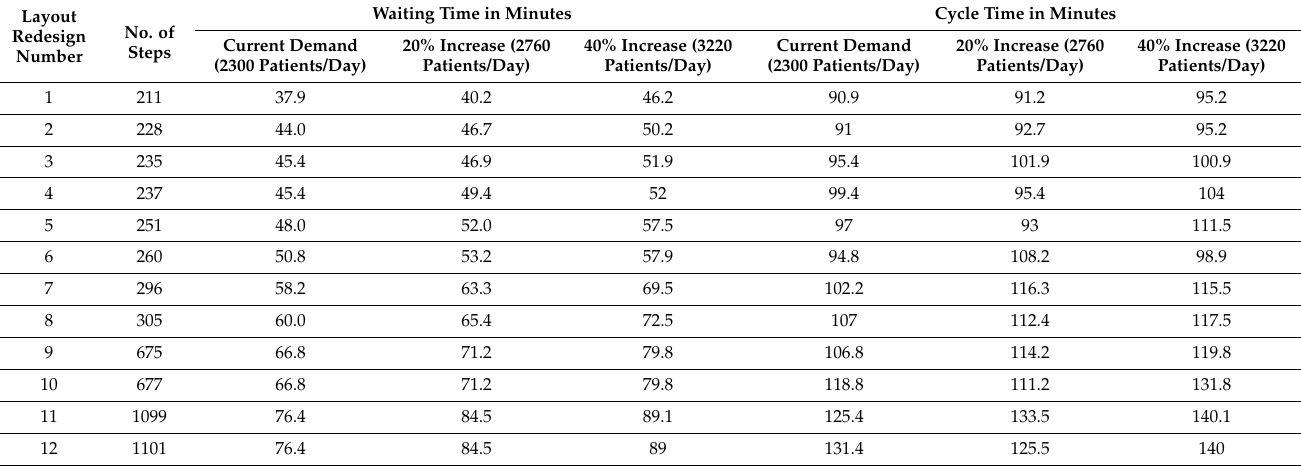
Table 3. Comparison of waiting time and cycle times with increase in demand for different layout redesigns.